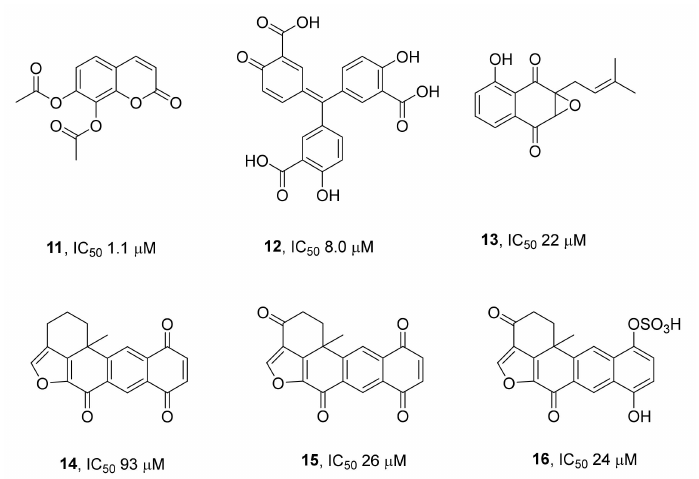
Figure 5. Natural phenolic compounds that inhibit